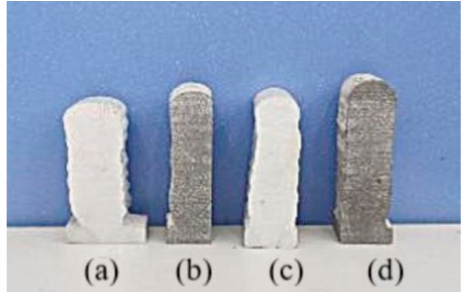
Figure 5. Macromorphology of deposited specimens with different processes. ( a ) Deposition speci- men with constant heat input and inter-layer cooling (Specimen A). ( b ) Deposition specimen with inter-layer cooling (Specimen B). ( c ) Deposition specimen with welding current for each layer reduced by 2 A (Specimen C). ( d ) Specimen with proposed deposition process (Specimen